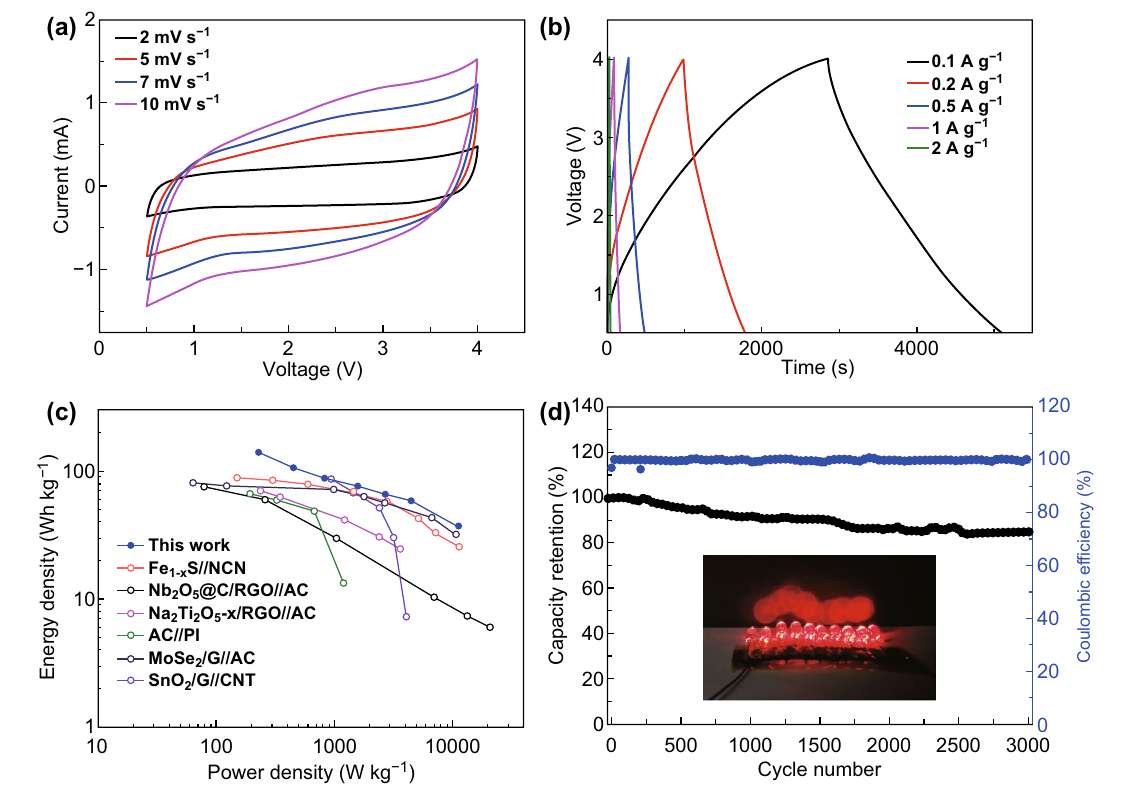
Fig. 5 a CV curves of MnS@NSC//NC SIC from 2 to 10 mV s −1 . b Charge/discharge profiles of MnS@NSC//NC SIC from 0.1 to 2 A g −1 . c Ragone plots of the SIC versus literature reported SICs. d Cycling stability test of the SIC at current of 2 A g −1 . The inset is the demonstration of 10 red LEDs powered by a charged